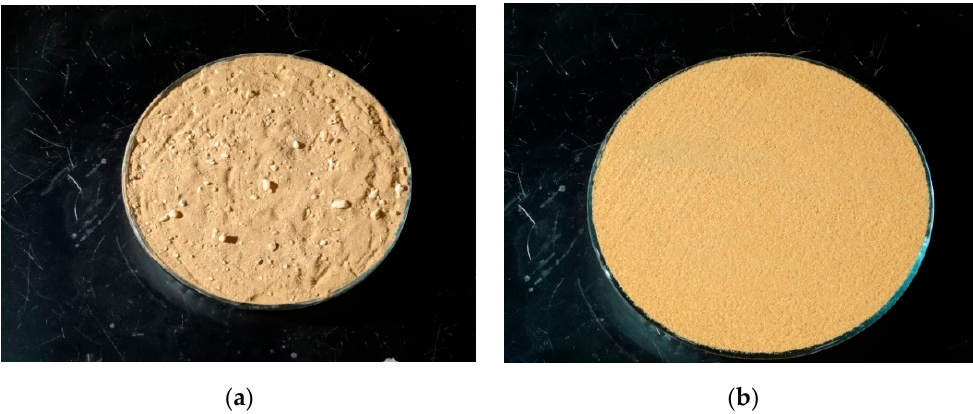
Figure 2. Examples of sand samples: ( a ) Namibia_RadCalNet; ( b ) Arabia_PICSAND1_SPL5.